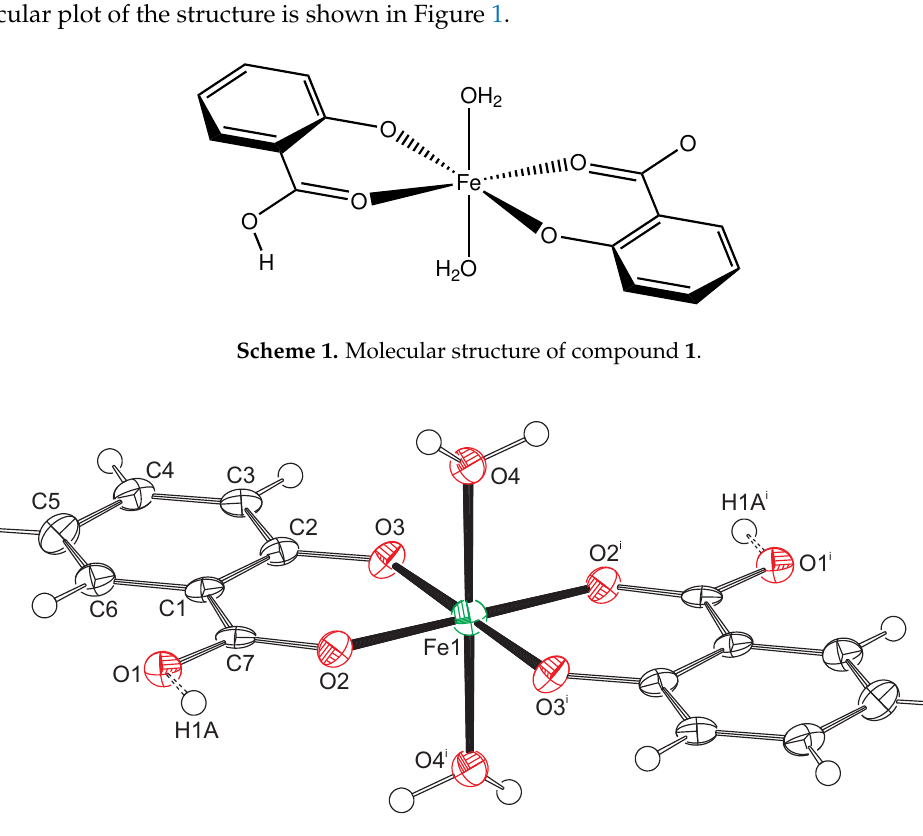
Figure 1. Displacement ellipsoid plot of compound 1 . Ellipsoids are drawn at the 50% probability level. Hydrogen atoms are drawn as small spheres with arbitrary radii. Atoms Fe1 and H1A are located on special positions. Consequently, only half of the O1 atoms are protonated. Symmetry code i : − x , 1 − y , − z